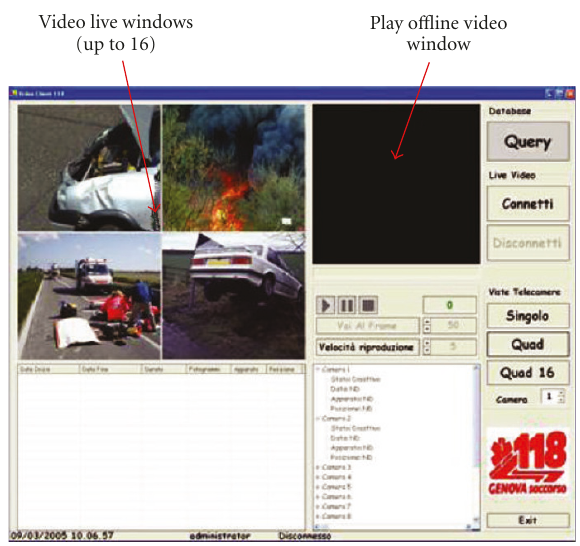
Figure 5: HMI for client in the hospital.